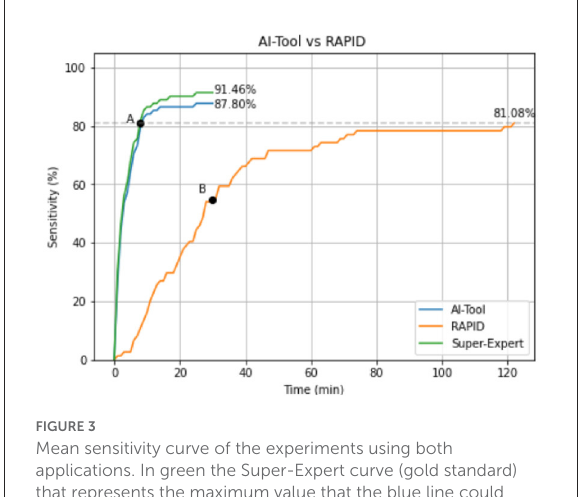
FIGURE3 Mean sensitivity curve of the experiments using both applications. In green the Super-Expert curve (gold standard) that represents the maximum value that the blue line could reach. This curve has been calculated simulating an expert who never makes mistakes when identifying a polyp while using the